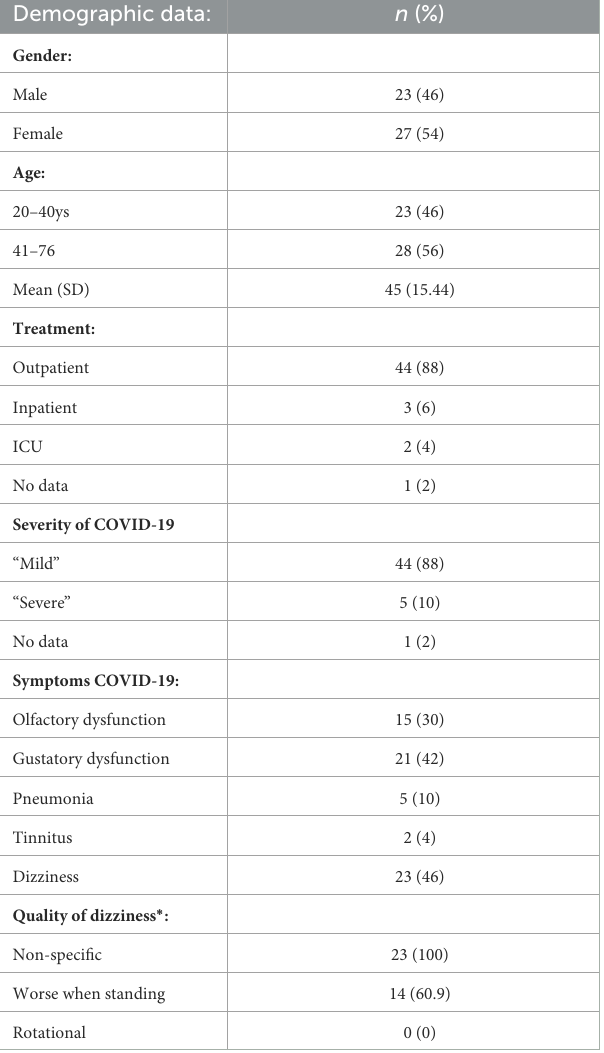
TABLE 1 Demographic data of 50 COVID-19